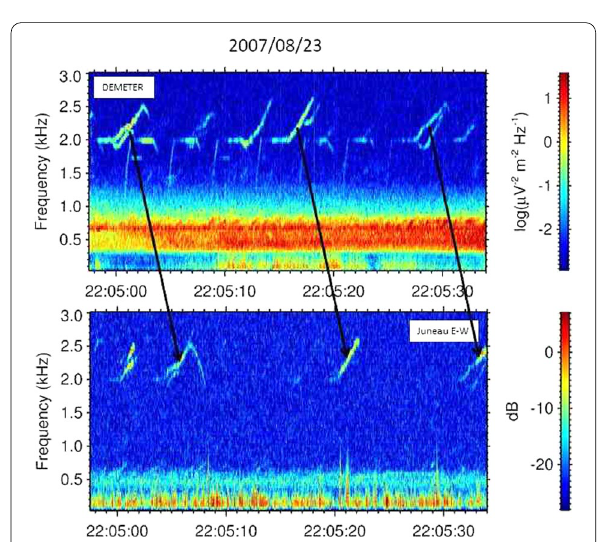
Fig. 4 Comparison with the spectrogram recorded by DEMETER in the Southern hemisphere (top panel) and at Juneau (bottom panel). The power spectral density is color-coded according to the scale on the right. The black arrows indicate the correspondence between triggered